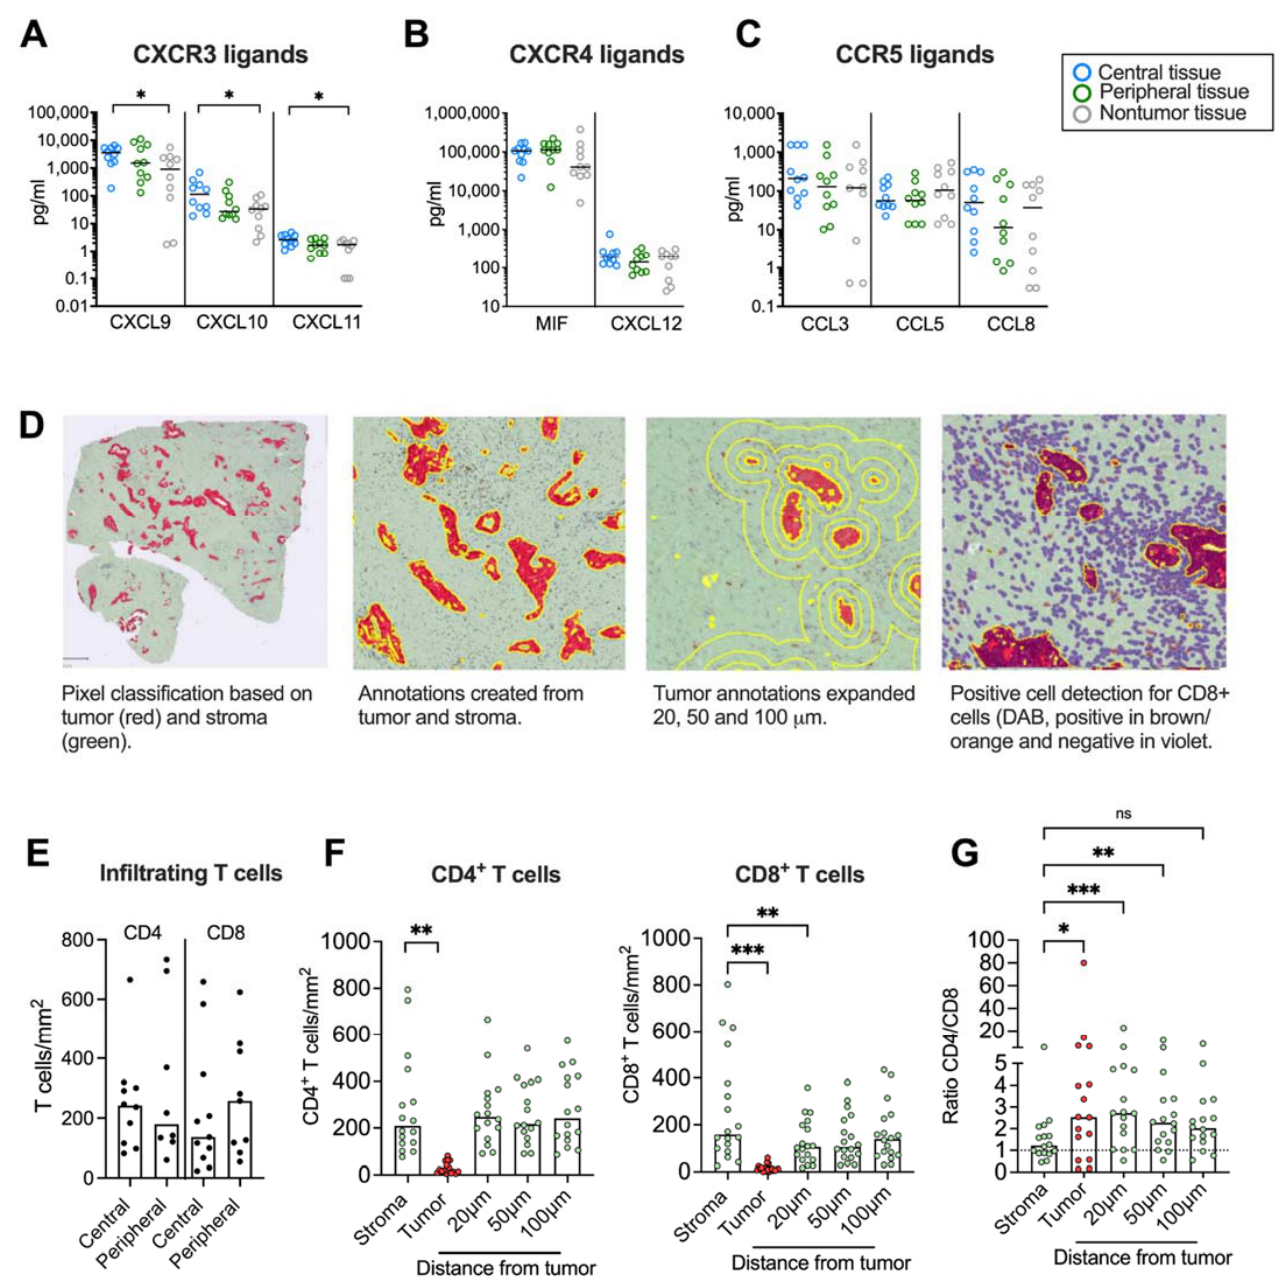
Figure 4. Immunohistochemical analyses of CD4 + and CD8 + T cells in tumor tissues. ( A – C ) Chemokine levels in conditioned medium from tumor tissues cultured for 48h. ( D , left ) Pixel classifi- cation based on tumor (CK19 in red) and stroma (green). ( Middle left ) Annotations to determine tumor and stroma. ( Middle right ) Annotations to show expanded tumor areas of 20, 50 and 100 µ m. ( Right ) Detection of CD8 + T cells in brown/orange. ( E ) Infiltrating CD4 and CD8 T cells in central and peripheral tumor tissues ( F ) Number of CD4 + and CD8 + T cells per mm 2 in total stroma, tumor nests (red), and 20, 50 and 100 µ m from the tumor nest. ( G ) Ratio of CD4 + /CD8 + T cells in total stroma, tumor nests (red), and 20, 50 and 100 µ m from the tumor nest. ( A – C , E ) Wilcoxon signed-rank test was used to detect statistically significant differences between paired samples. ( F ) Friedman’s test was used to detect statistically significant differences. ns, not significant. * p < 0.05, ** p < 0.01, *** p <